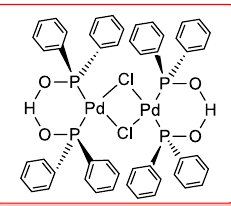
Figure 4. Phosphinito palladium(II) complex as the catalyst for acyl Sonogashira coupling.